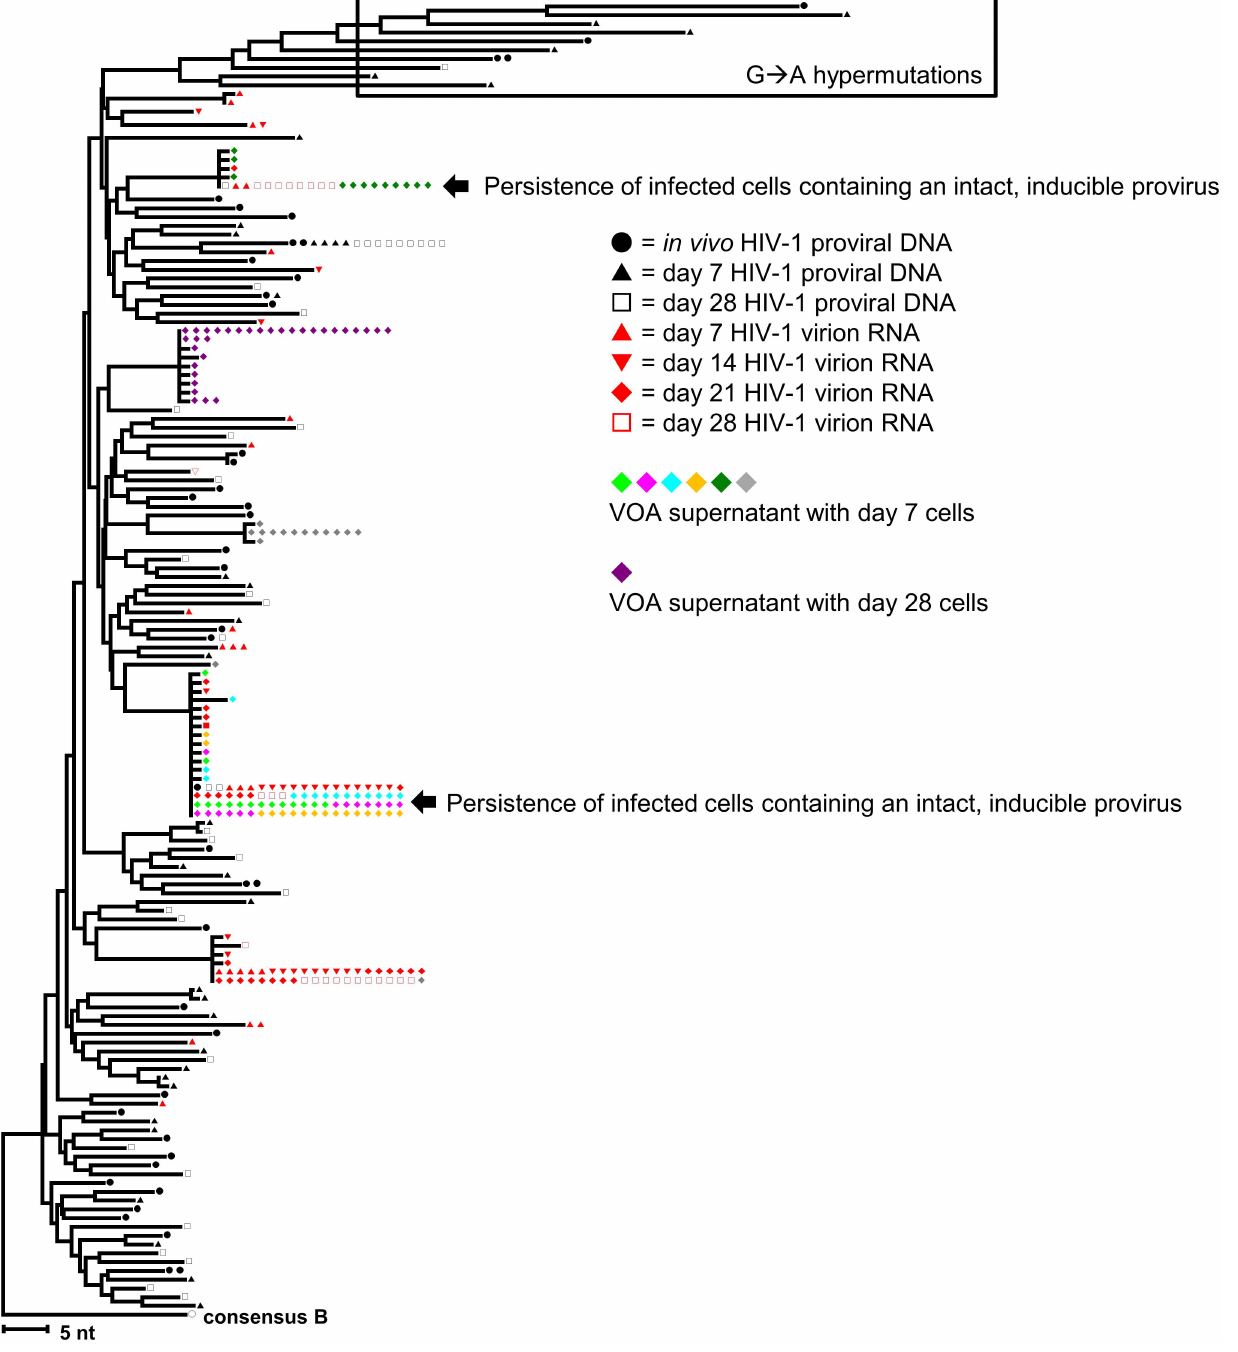
Fig 6. Neighbor-joining distance tree of virion-associated HIV RNA and proviral-associated HIV DNA sequences illustrates proviral population dynamics after CD4 + T-cell activation (Donor 1). The tree was constructed using the neighbor-joining p-distance method. All sequenceswere rooted to a consensussequenceof HIV subtype B. Hypermutant sequencesare boxed. The Viral Outgrowth Assay (VOA) was performed using day 7 and day 28 cells from Donor 1 (Experiment 2) total CD4 + T-cells. The day 7 cells were seeded into 6 wells at 1x10 6 cells/welland the day 28 cells were seeded into 6 wells at 3x10 5